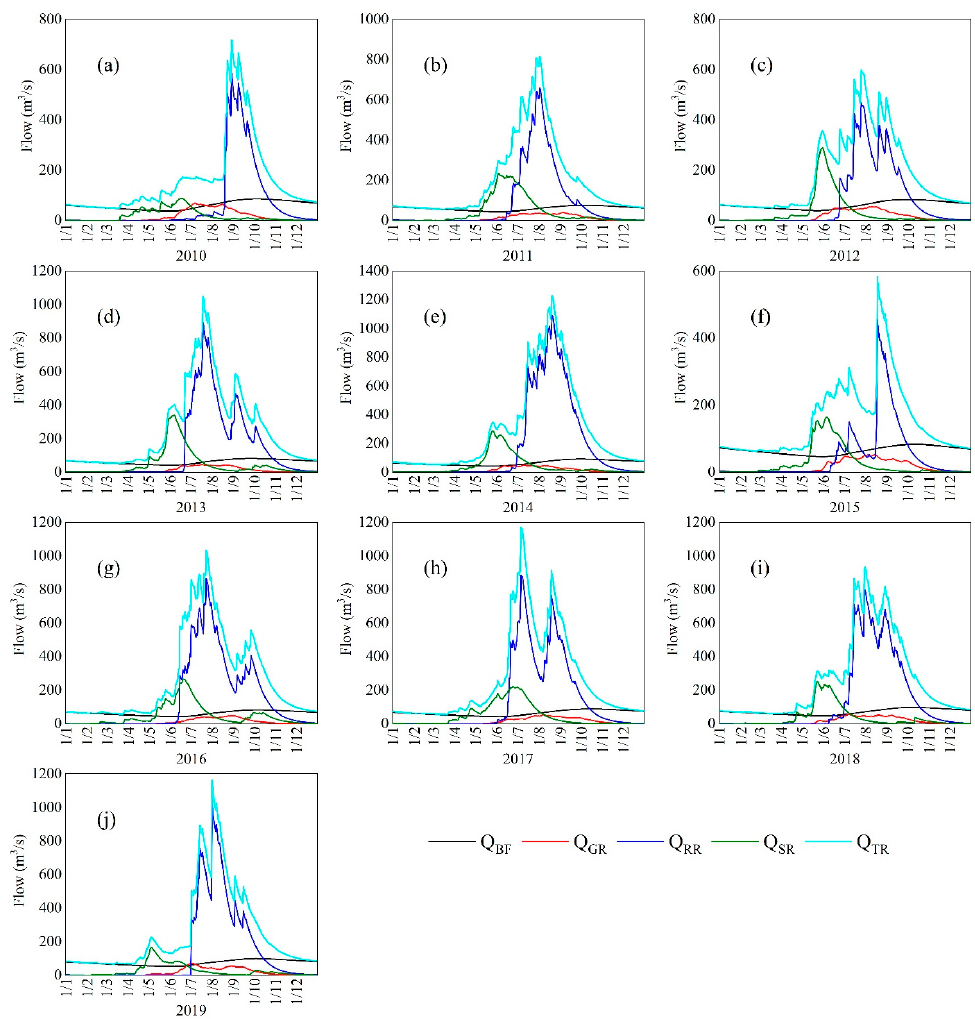
Figure 7. Annual variations in baseflow (Q BF ), glacier melt runoff (Q GR ), rainfall-runoff (Q RR ), snowmelt runoff (Q SR ), and total runoff (Q TR ) simulated during 2010–2019. ( a – j ) represent the division results of daily runoff from 2010 to 2019.